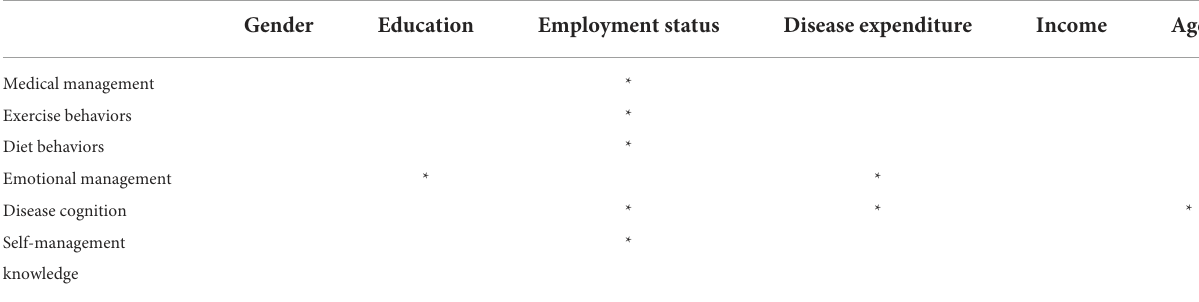
TABLE 3 All F -test results.